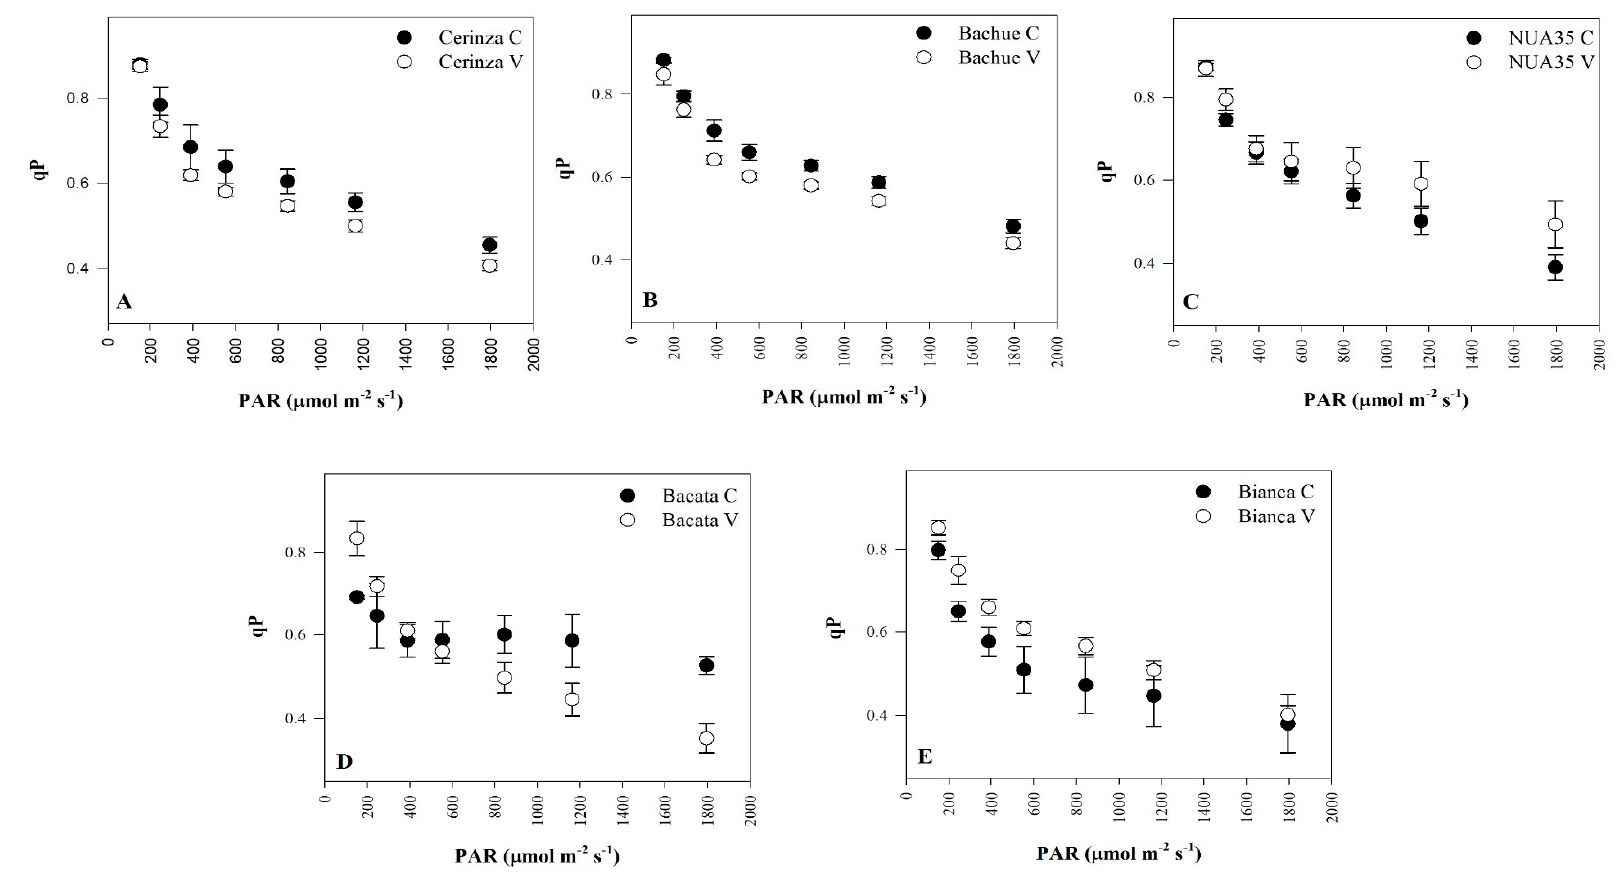
Figure 4. Photochemical quenching (qP) obtained from rapid light-response curves of ‘Cerinza’ ( A ), ‘Bachue’ ( B ), ‘NUA35’ ( C ), ‘Bacata’ ( D ) and ‘Bianca’ ( E ) under two water treatments (control ( (cid:8) ) and water-stressed ( ) plants) at the end of vegetative stage (55 DAE). Data represent the mean of four data points ± standard error. (cid:35)